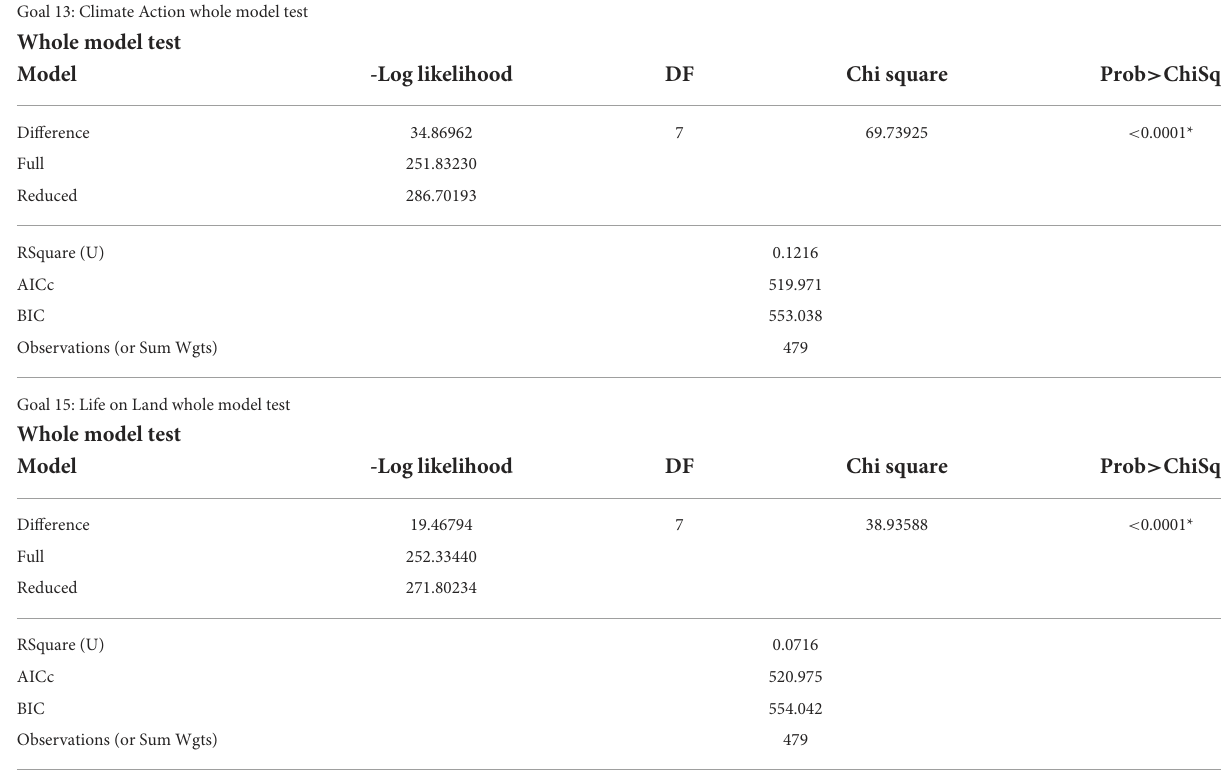
TABLE 5 Whole model test on the likelihood of RCE projects to focus on specific audiences of learners for SDG 13 (Climate Action) and SDG 15 (Life on